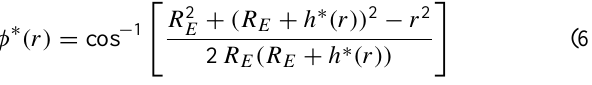
Fig. 5. A comparison of the variation of virtual height and ground range with range between the measured Saskatoon beam 3 backscat- ter distribution (colour contours) and the standard SuperDARN vir- tual height model (blue line). (top) The virtual height distribu- tion of Saskatoon beam 3 backscatter from 1997–2001 inclusive (adapted from Fig. 4). 1 -hop backscatter is assumed up to a range 2 of 2135km (vertical dotted line), whereas 1 1 -hop backscatter is 2 assumed at higher ranges. At higher ranges two distributions are shown. The “True” virtual height distribution is the same as in the lower panel of Fig. 4. The “Pseudo” virtual height distribution is the -hop distribution of virtual heights that need to be assumed for 1 1 2 backscatter in order to retain the correct ground range when using a 1 -hop backscatter assumption for estimating the ground range. 2 (middle) The ground range distribution for the same data set. (bot- tom) The ground range difference distribution showing the range of errors that result from application of the SuperDARN standard virtual height model. Here, the blue line represents the measured distribution and the contours represent the differences that occur from using the standard virtual height model. (all panels) Only common mode backscatter with a line-of-sight velocity magnitude greater than 100m/s are included. The distribution in each range bin (45km) has been normalised. The colour scale provides a key to the occurrence probability in each region; occurrence probabili- ties of less than 0.014 are shown as white